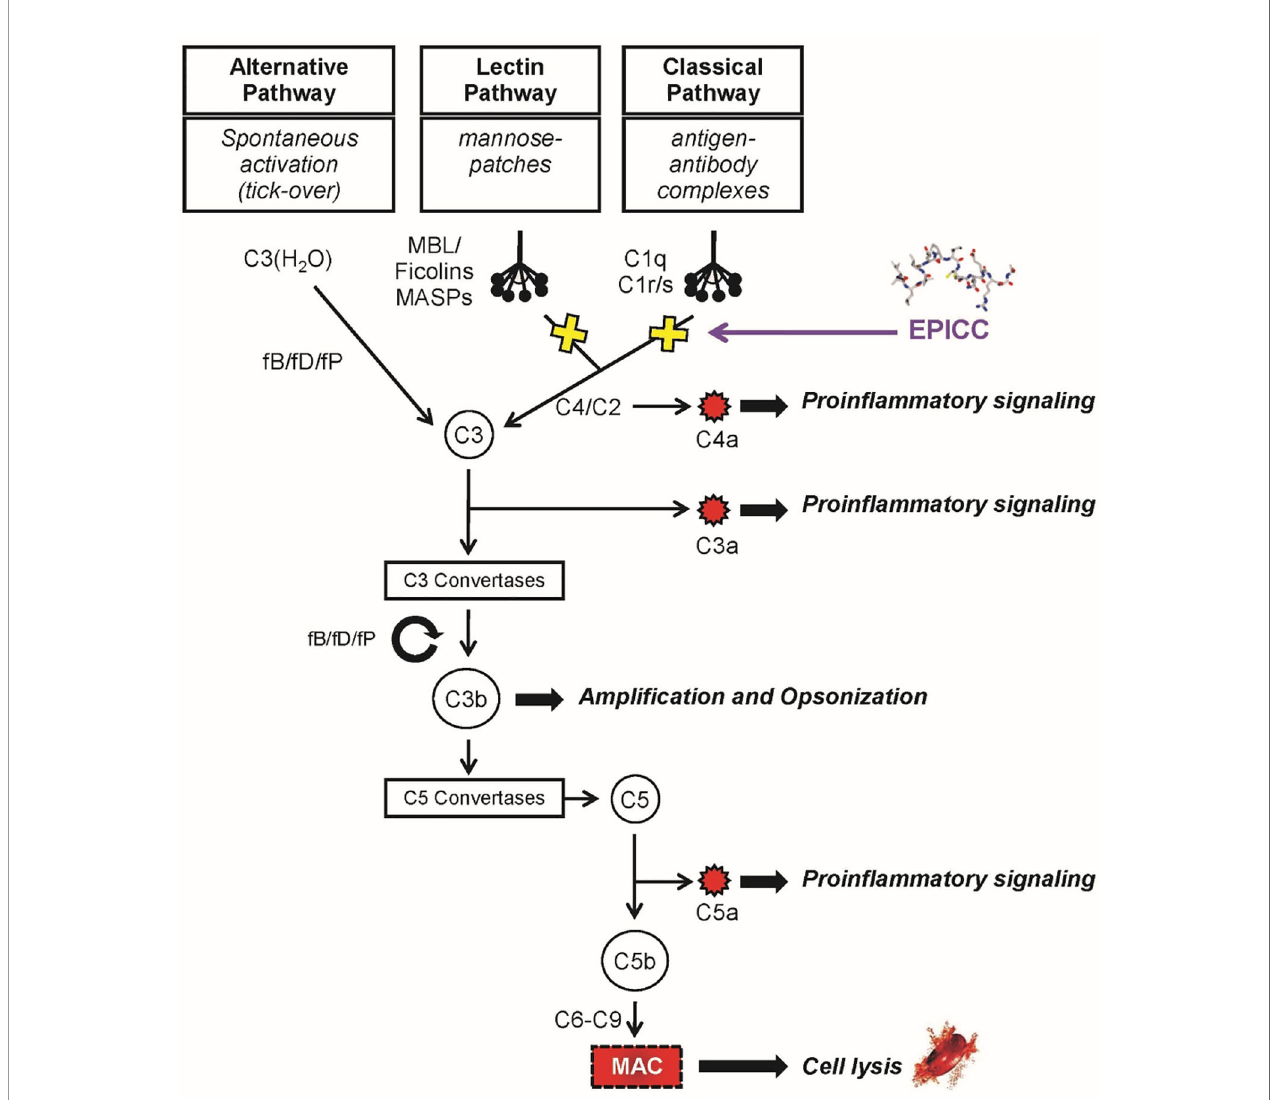
FIGURE 1 | The complement system. The alternative, lectin and classical pathways with the main protein factors and effector functions are indicated. The EPICC peptides speci fi cally bind to the initiator molecules of the classical and lectin pathways, C1q and MBL, respectively, inhibiting complement activation and downstream effector functions. The EPICC compounds do not interfere with the essential immune surveillance functions provided by the alternative